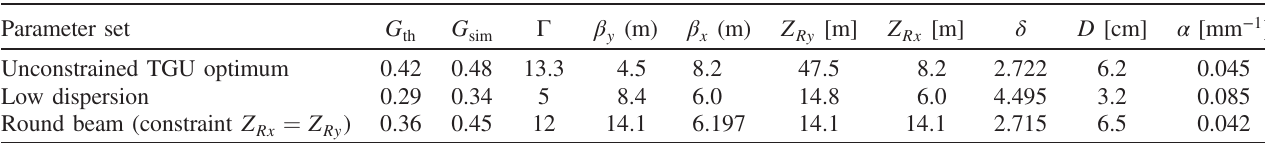
TABLE II. Optimized TGU parameter sets. From left to right, the columns are gain from numerical integration G G , TGU parameter Γ , electron beta functions β sim gradient α .